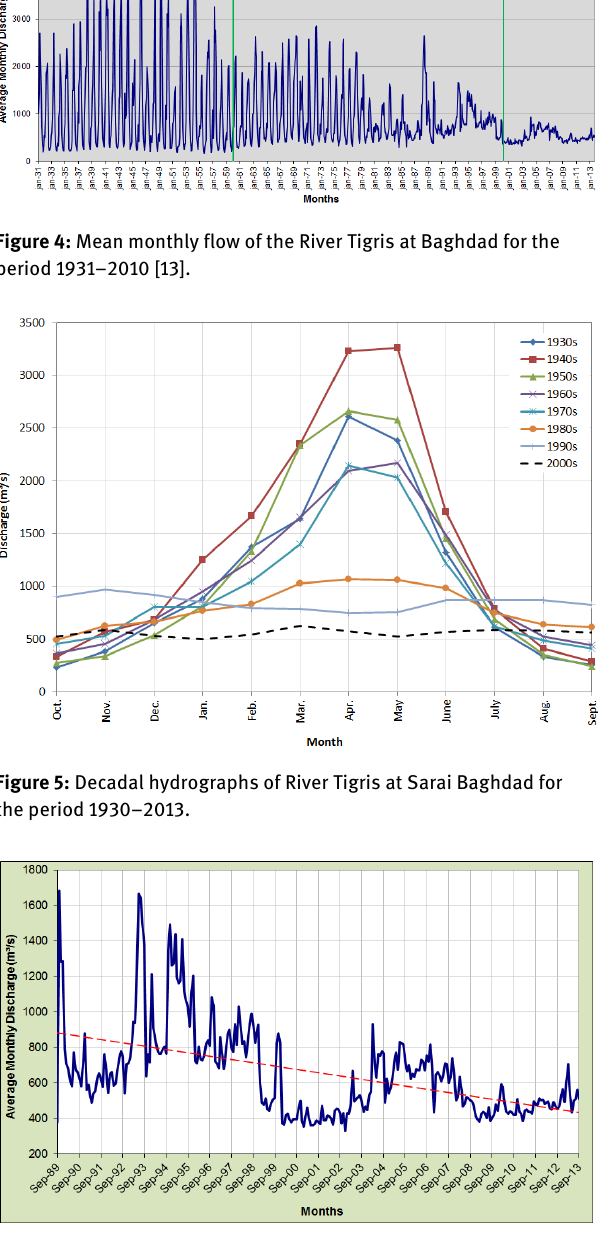
Figure 6. Trend line for the average monthly discharges at Sarai Baghdad for the period 1989-2013 Figure 6: Trend line for the average monthly discharges at Sarai (Modified after [14]). Baghdad for the period 1989–2013 (Modified after